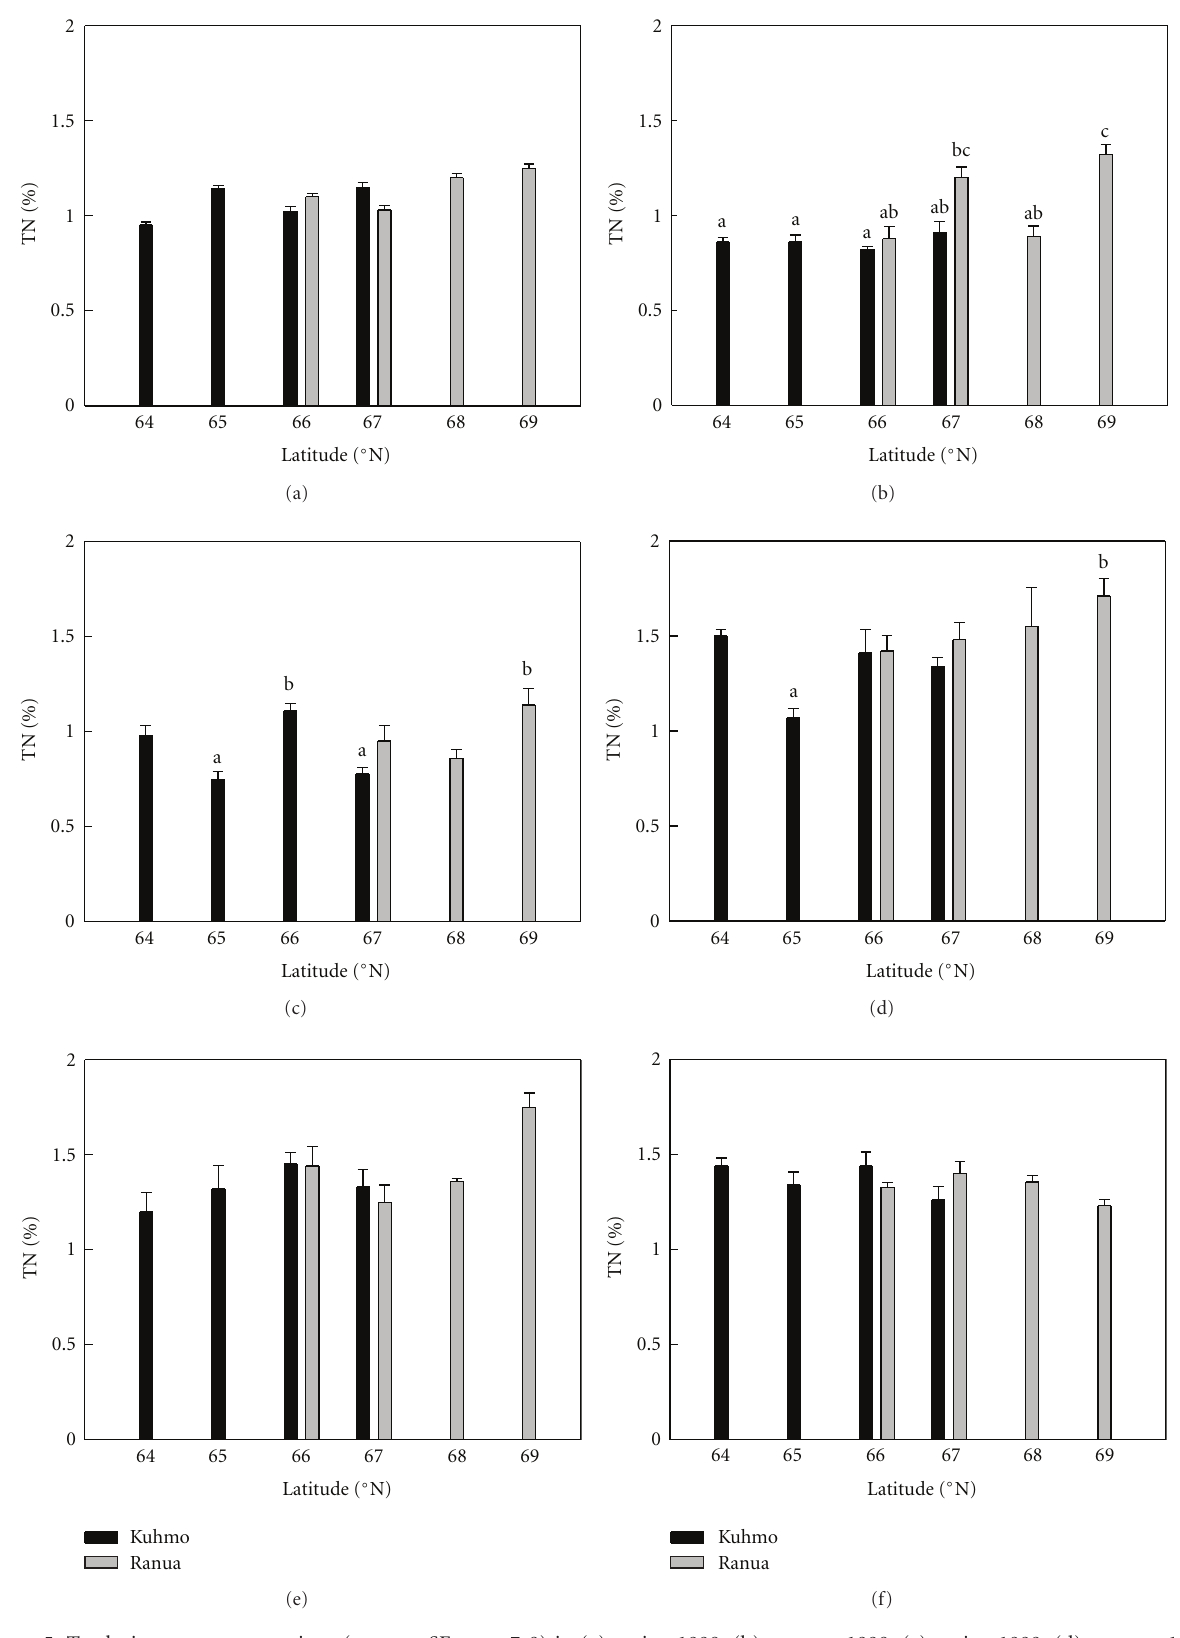
Figure 5: Total nitrogen concentrations (mean ± SE, n = 7-8) in (a) spring 1998, (b) autumn 1998, (c) spring 1999, (d) autumn 1999, (e) spring 2000, and (f) autumn 2000. Di ff erent letters indicate di ff erence at P < .